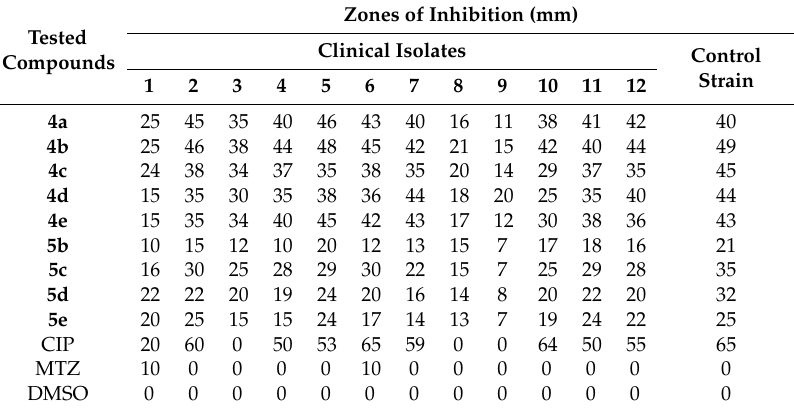
Table 1. Zones of inhibition (mm) of synthesized compounds (1 mg/mL), ciprofloxacin, and metronidazole against clinical strains of H. pylori (1–12) and control strain. Zones of Inhibition (mm) Tested Clinical Isolates Control Compounds